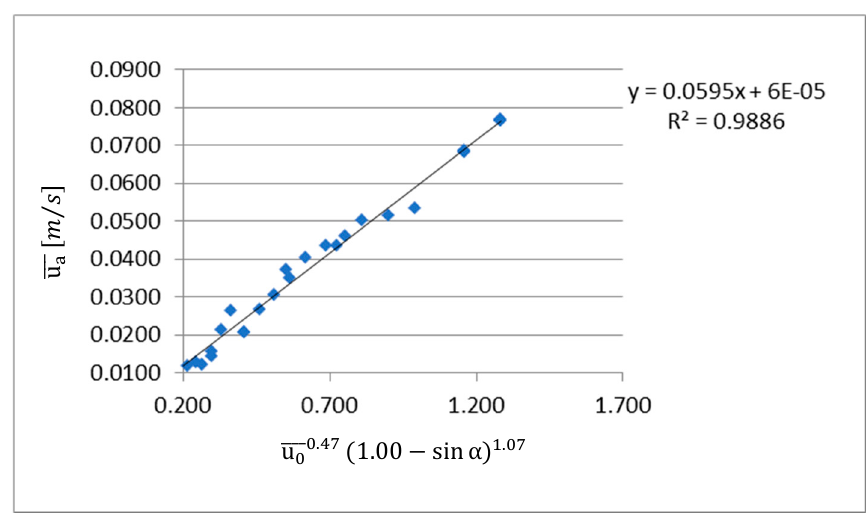
Figure 12. Linear regression between average velocity at the opening and u 00.47 ( 1.00 − sin α ) 1.07 .